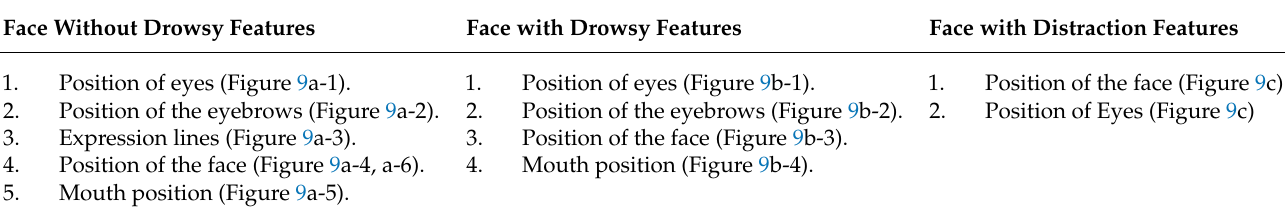
Table 2. Specific features considered in each of three states of the driver.